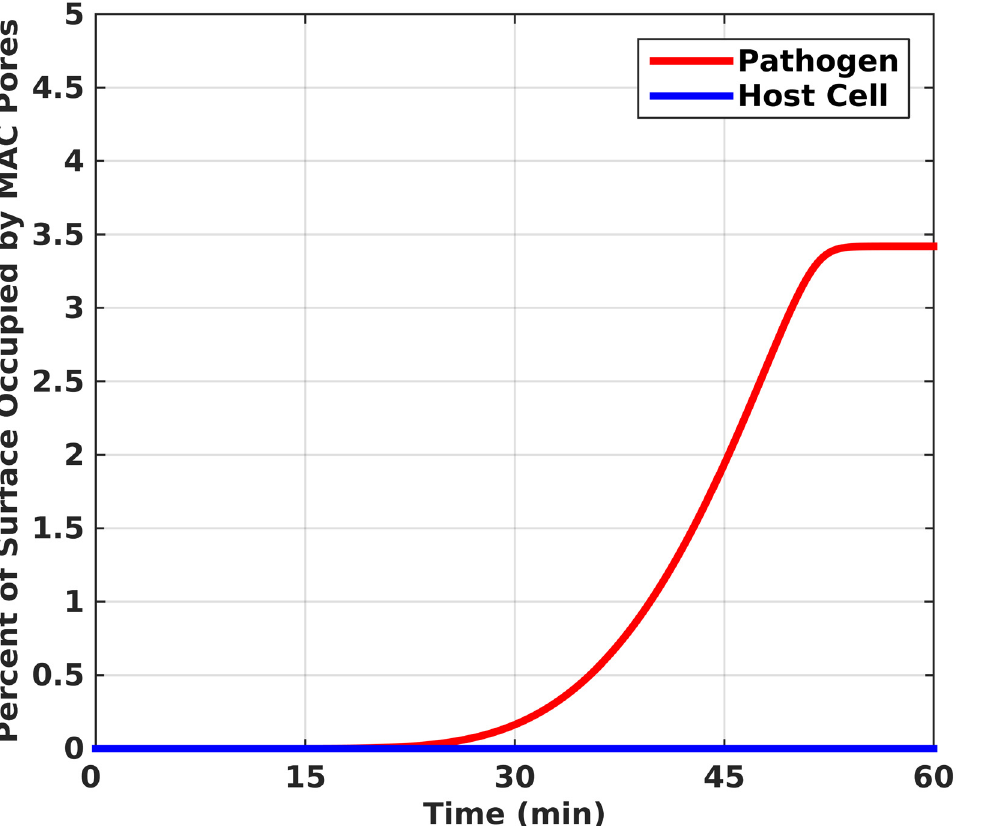
Fig 7. Formation of MAC pores is characterized by three phases: lag phase, production phase, and a steady state phase. The first 22 minutes present a lag phase that is followed by a rapid production of MAC pores, which plateaus in 54 minutes and occupies 3.3 percent of the pathogen surface. However, on host cells the MAC pores take significantly less than 1